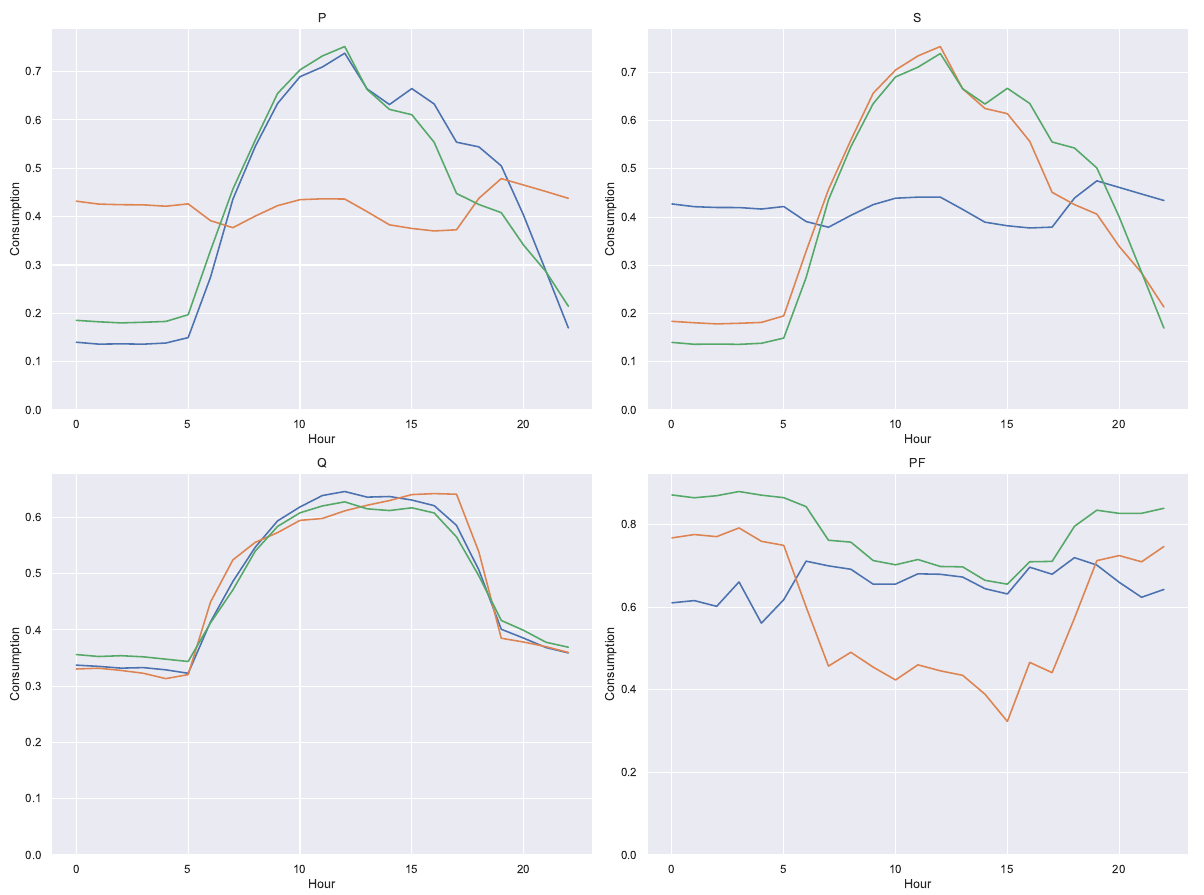
Figure 18. Prototype clusters obtained with the extended variables in Scenario A. Each color repre- sents a single cluster.